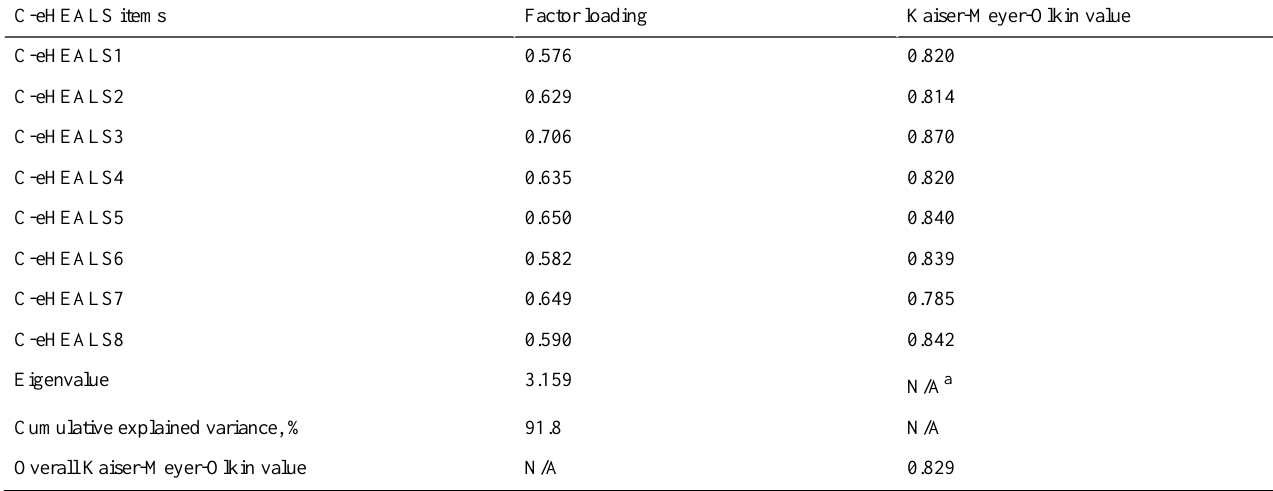
Table 3. Principal components analysis and Kaiser-Meyer-Olkin test of the C-eHEALS items.